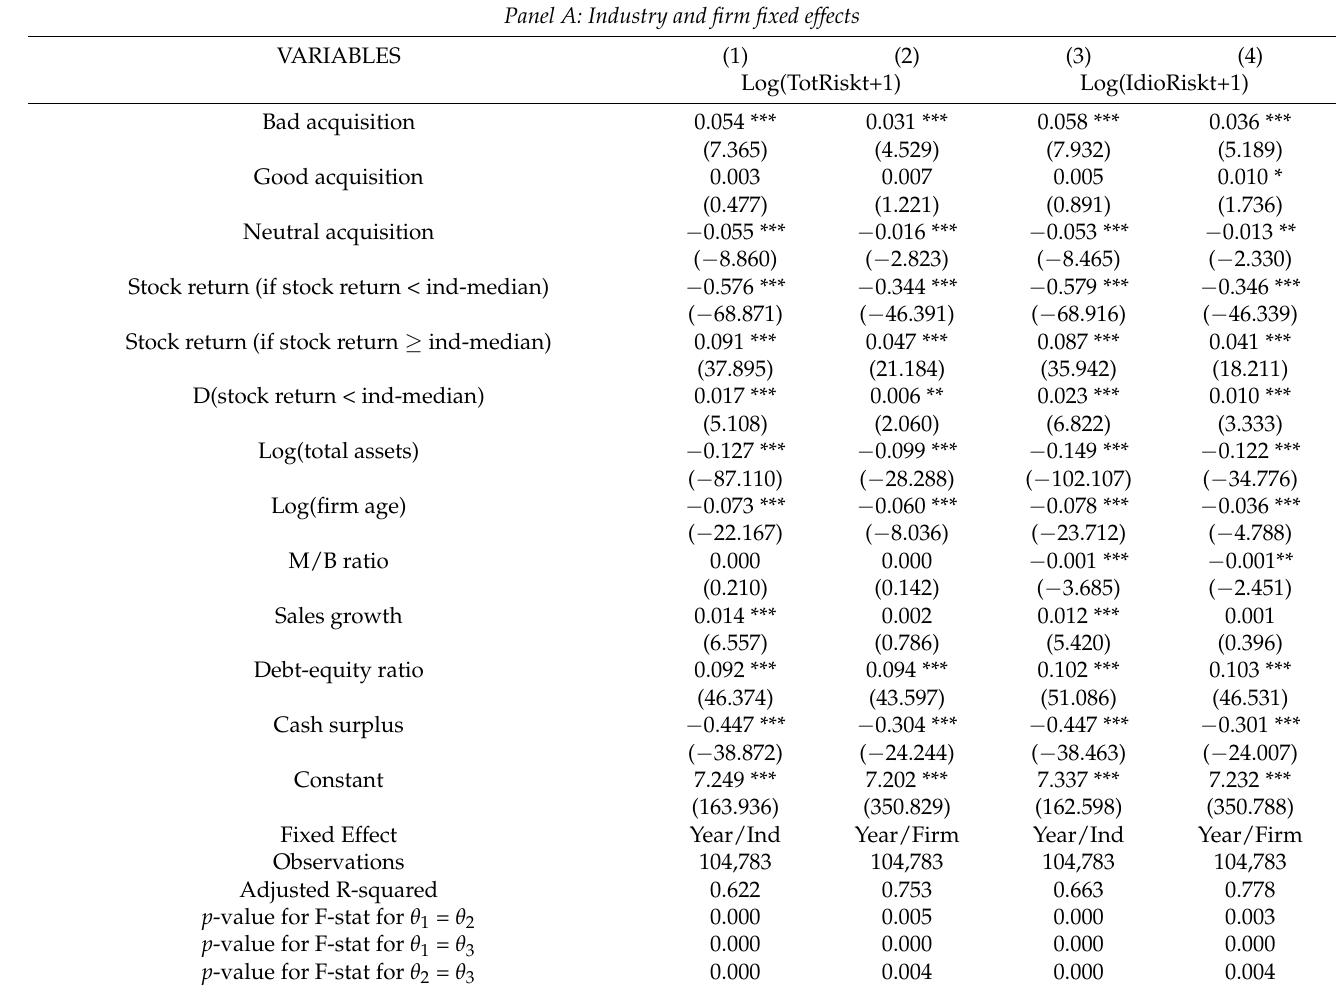
Table 3. Firm risk and market reaction to acquisitions. This table presents the OLS regression results for the sample of firm-year observations between 1990 and 2015. Variable definitions are in the Appendix A. All regressions control for fiscal-year fixed effects and industry/firm fixed effects whose coefficients are suppressed for brevity. t-statistics based on standard errors adjusted for heteroskedasticity (White 1980) and firm clustering are reported in parentheses. *, **, and *** denote statistical significance at the 10%, 5%, and 1% levels,